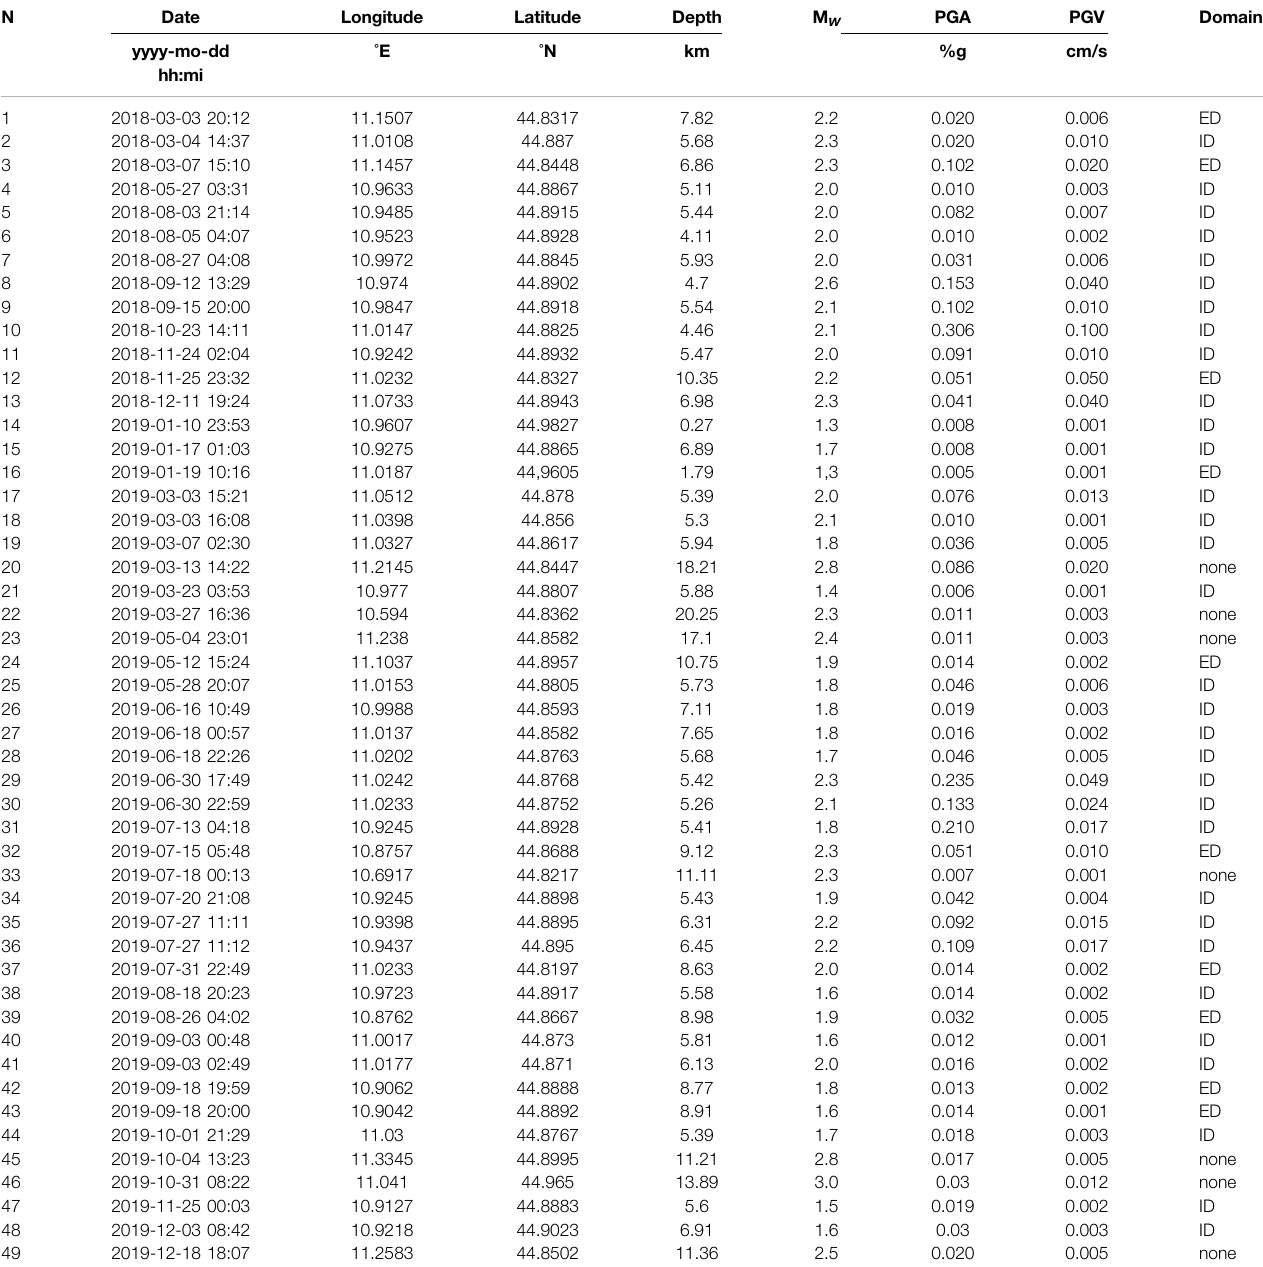
TABLE 1 | List of the 49 earthquakes analysed in during 2018 – 2019. The date is expressed in year-month-day, then we report location estimates (longitude, latitude and depths in km), M W , PGA in g percentages and PGV in cm/s. The last column report the domain where the hypocenter location falls (ID, ED, or none of the